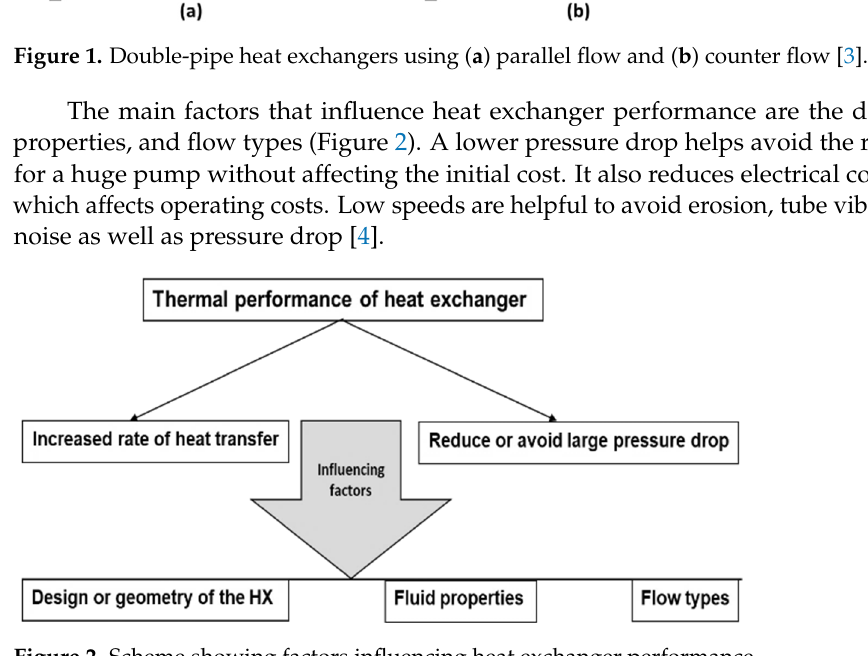
Figure 2. Scheme showing factors influencing heat exchanger performance.